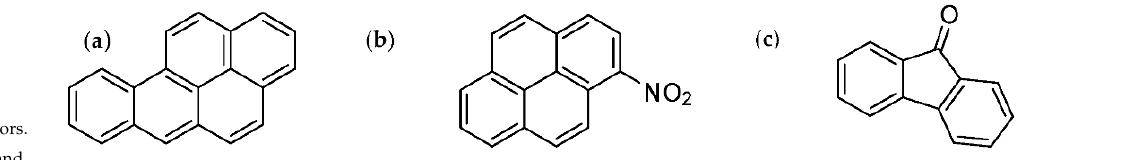
Figure 1. Examples of chemical structures of polycyclic aromatic hydrocarbons